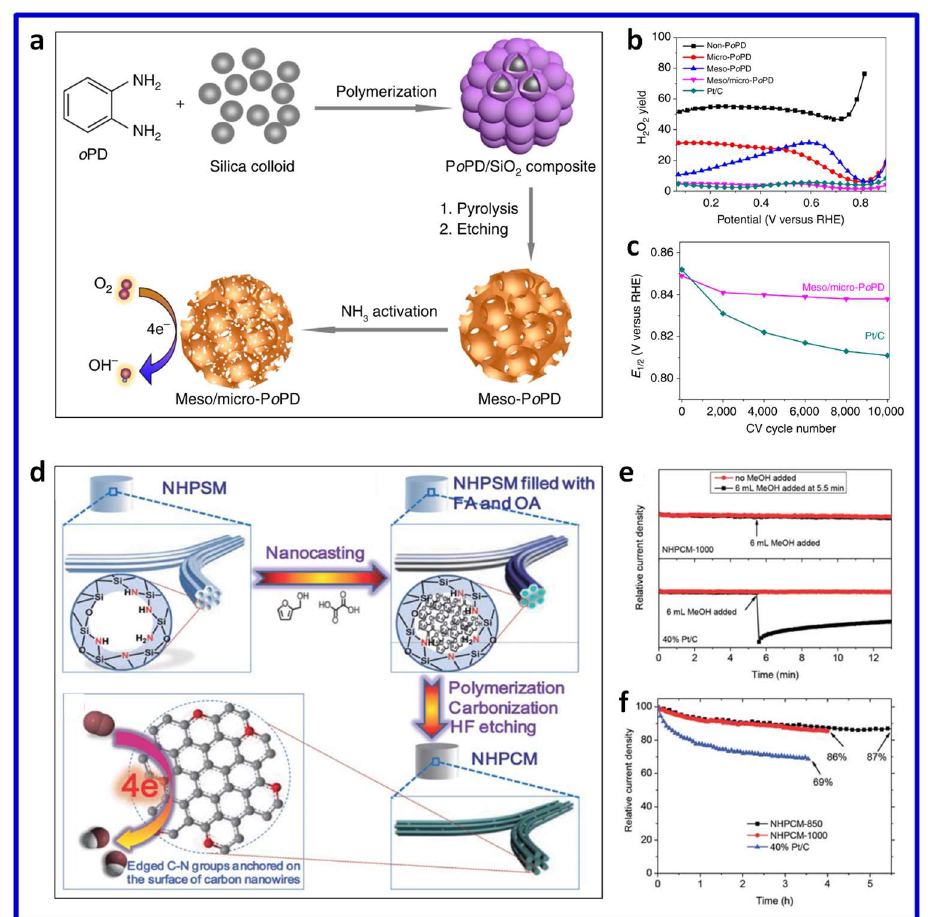
Figure 8. ( a ) Schematic illustration of the synthesis of meso/micro-N-doped carbon (P o PD) electrocatalyst; ( b ) H 2 O 2 yields plots of meso/micro-P o PD, reference materials, and Pt/C catalyst; ( c ) Half-wave potential of meso/micro-P o PD and Pt/C with the same loading of 0.1 mg cm -2 as a function of the number of potential cycles in O 2 -saturated electrolyte. Reproduced from [102], Copyright 2014, Macmillan Publishers Limited; ( d ) Schematic illustration of the synthesis of 3D N-doped hierarchical porous carbon monolith (NHPCM) electrocatalyst; ( e ) Current–time chronoamperometric response of NHPCM-1000 and Pt/C with or without the addition of 6 mL MeOH into the electrochemical cell containing 100 mL electrolyte at 0.6 V (vs. RHE) with a rotating rate of 1600 rpm; ( f ) Current–time chronoamperometric response of NHPCM-850, NHPCM-1000, and Pt/C over 3.5 h at 0.6 V (vs. RHE) in O 2 -saturated 0.1 M KOH solution at 1600 rpm. Reproduced from [103], Copyright 2015, Wiley.